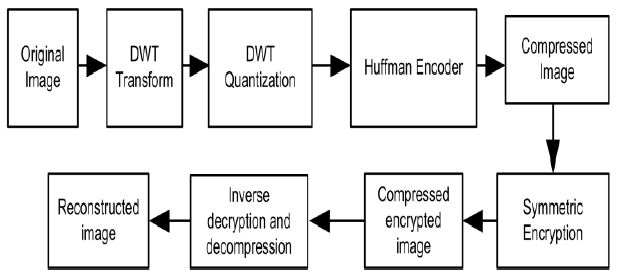
Figure 1. Block diagram of proposed architecture